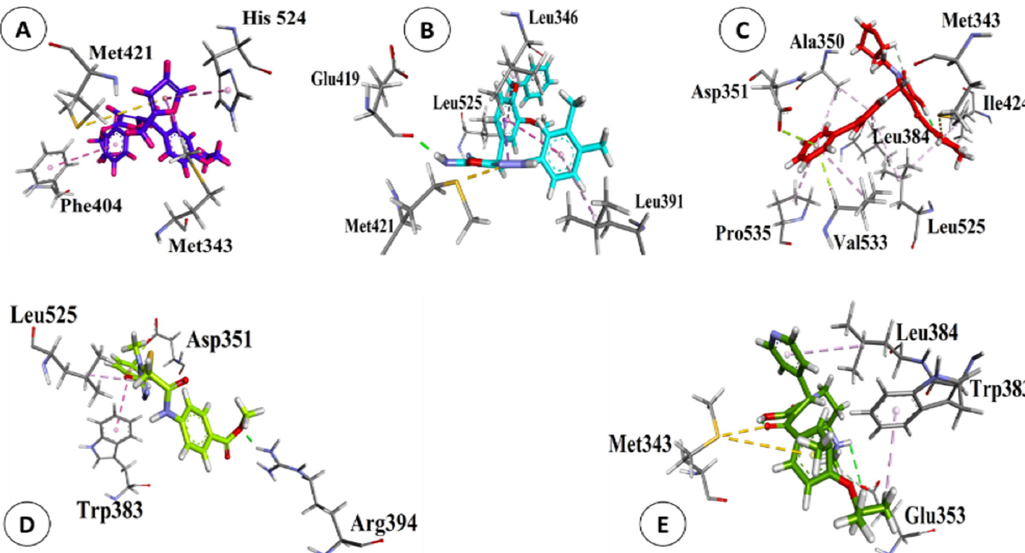
Figure 4. Three-dimensional interactions of synthetic compounds ZINC08441573 ( A ), ZINC00664754 ( B ), ZINC00702695 ( C ), ZINC00627464 ( D ), and ZINC08440501 ( E ) with the binding site of ER α protein.